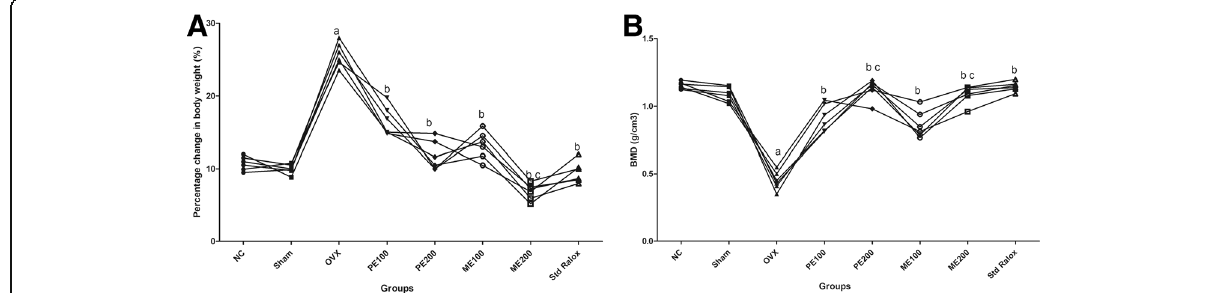
Fig. 4 Effect of plant extracts of B. ceiba on ( a ) percentage change in body weight; and ( b ) bone mineral density. Results: mean ± SD, analyzed by one-way ANOVA followed by Bonferroni ’ s multiple comparison tests; a p < 0.05 vs. Sham; b p < 0.05 vs. OVX; c p > 0.05 vs. Std Ralox